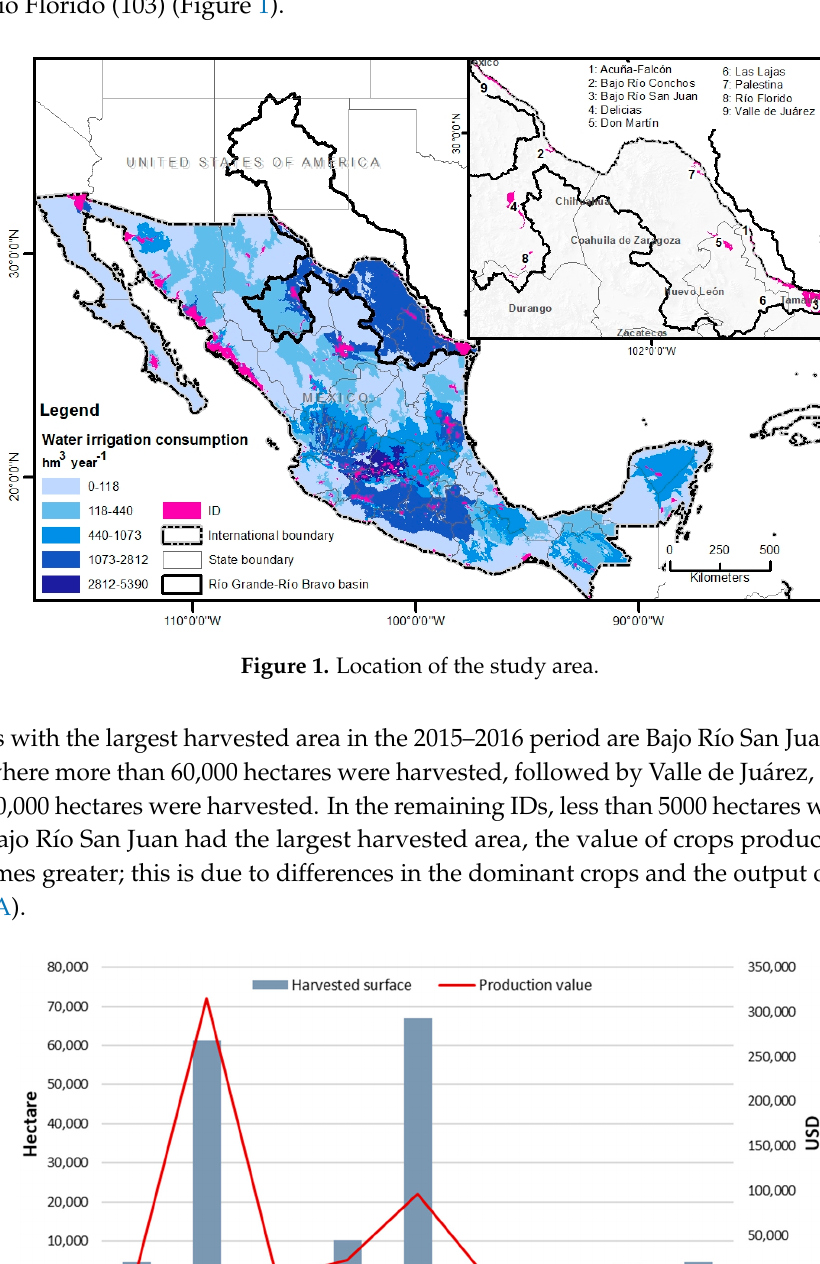
Figure 2. Harvested area in hectares per irrigation district of the Rio Bravo Basin for the 2001–2016 crop years.